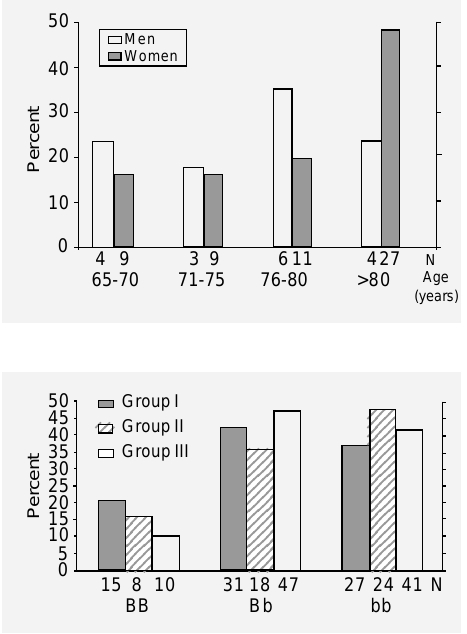
NFigure 2 - Distribution of vitamin D receptor gene polymorphism among the three groups studied (group I = elderly subjects with FPF, group II = elderly subjects without FPF and group III = young healthy